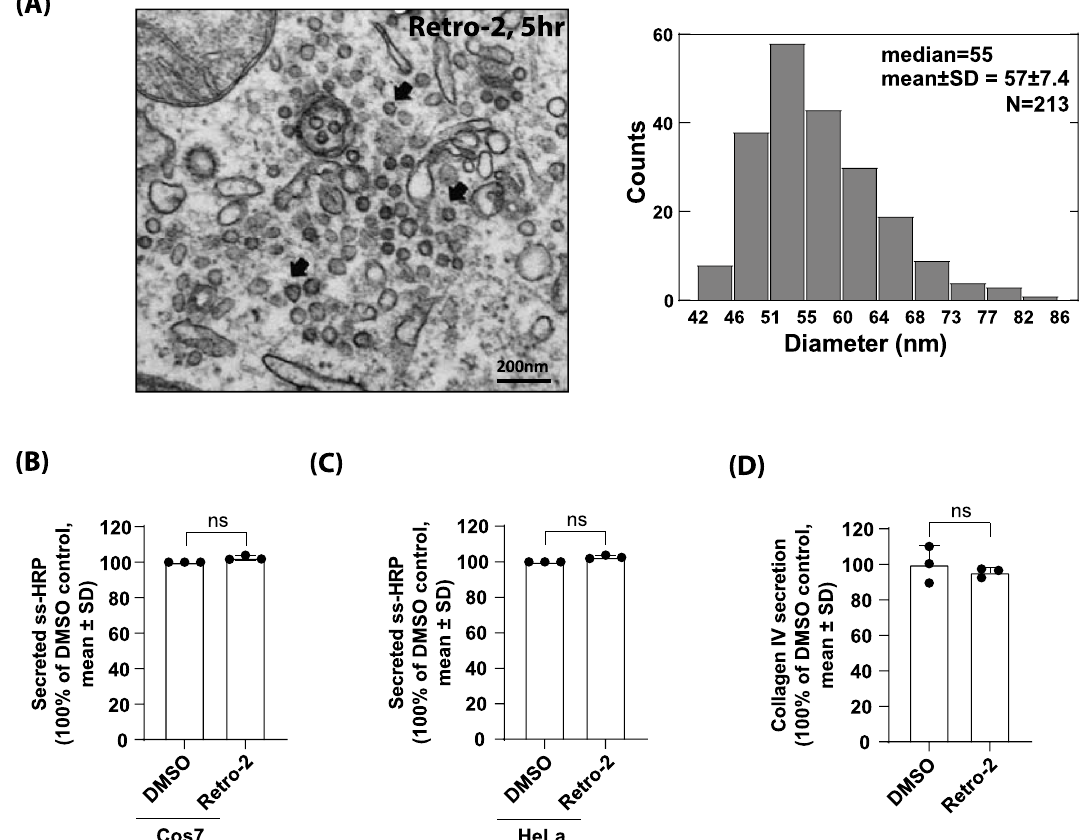
Figure 2. Retro-2 treatment induces COPI-like vesicles accumulation in the peri-Golgi region and does not affect anterograde secretion of cargo proteins. ( A ) Size distribution analysis of Retro-2-induced vesicular profiles suggest that a large fraction of these accumulated vesicles are likely to be uncoated COPI vesicles. For diameter distribution of the vesicles, we measured maximum diameter from membrane to membrane. Distribution median value is 55 and mean value is 57 nm (n = 213) (scale bar 200 nm). ( B , C ) Retro-2 treatment does not affect secretion of soluble secretory cargo, ss-HRP, in HeLa or COS7 cells. Cells were transfected